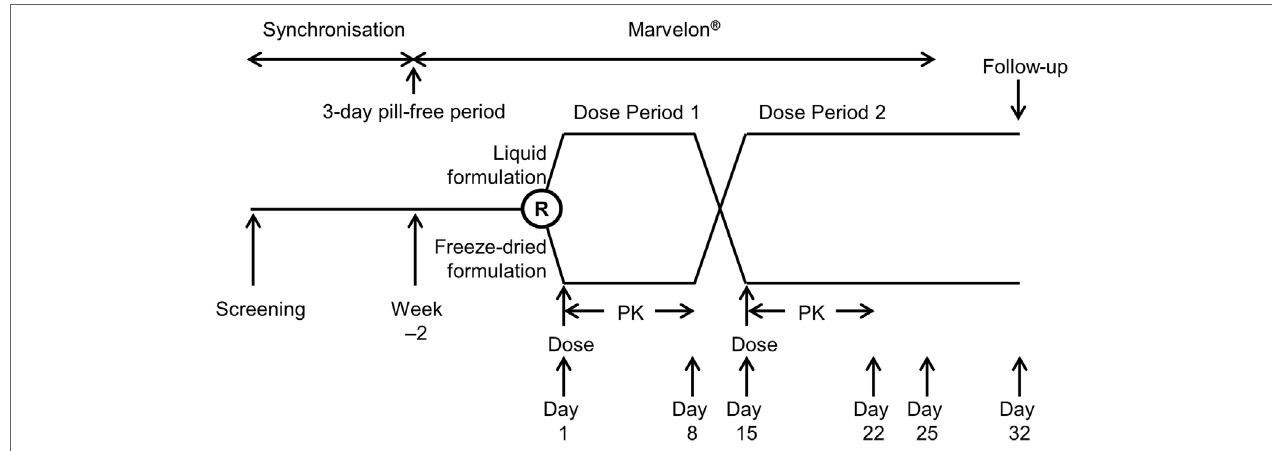
FigUrE 1 | Study design. PK, pharmacokinetic; R,